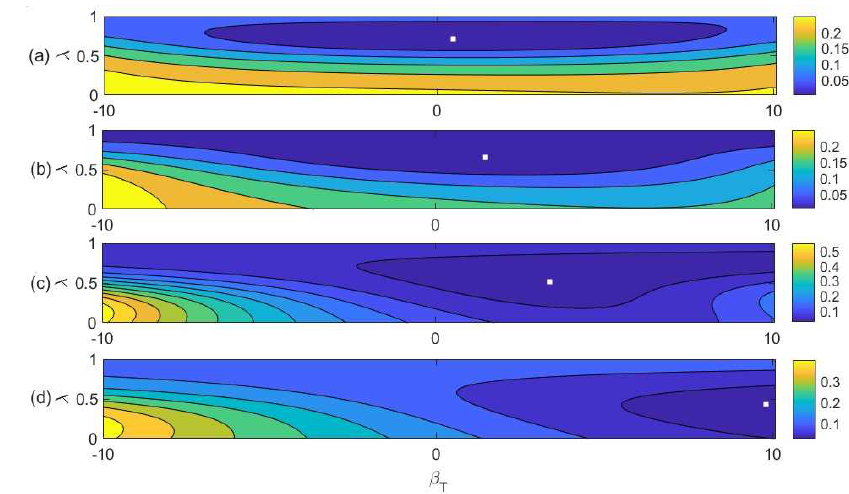
Figure 5. Heat-map plots of the mean square SNR error F ( x ) as a function of λ vs. β T after fixing the β L , σ T and σ L at the extracted optimal values for azimuth ( a ) 0 ◦ , ( b ) 10 ◦ , ( c ) 20 ◦ and ( d ) 30 ◦ . White dots are the optimal λ and β T values extracted from the model.